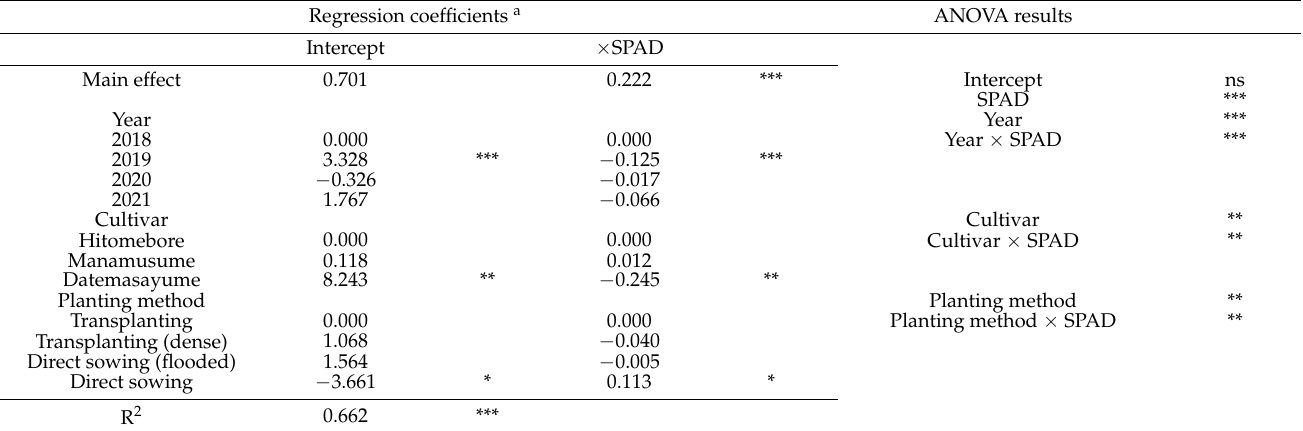
Table 4. Regression coefficients and ANOVA results by Equation (2) for milking